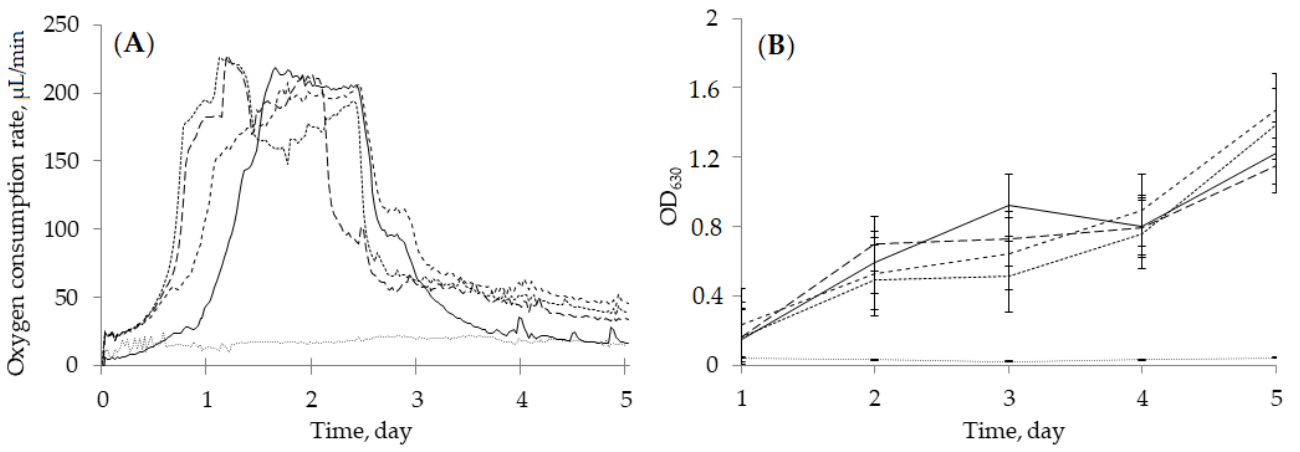
Figure 6. Oxygen consumption rate ( A ) and growth dynamics ( B ) of R . rhodochrous IEGM 1362 in the presence of (‒) -isopulegol and HNTs ( ), (‒) -isopulegol ( ), and HNTs ( ). Biotic control ( ), abiotic control ( ).